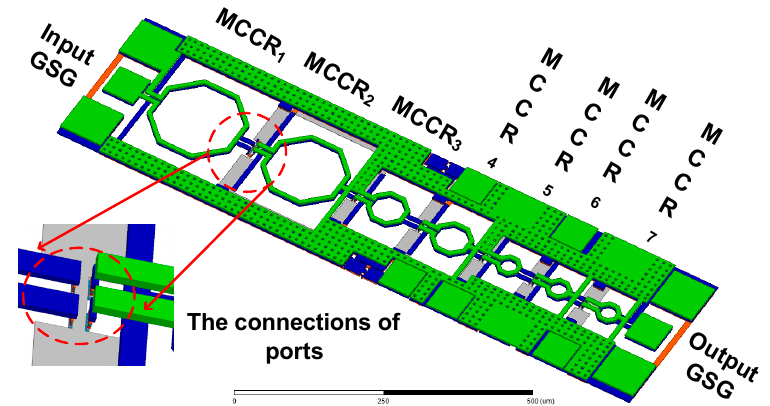
Figure 9. Passive structure with MCCR 3D EM model. (GSG: Ground-Signal-Ground)